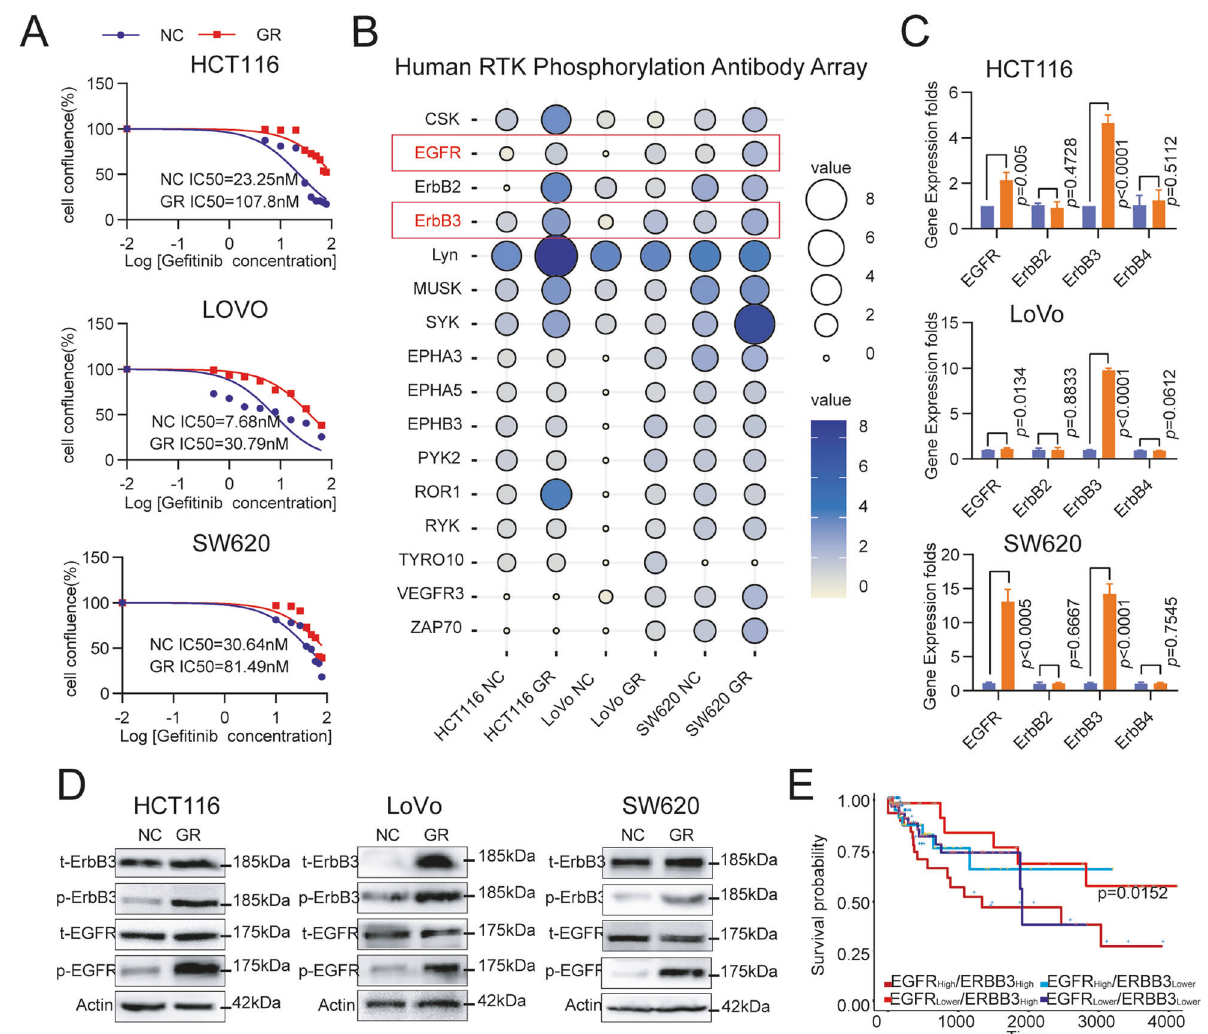
Fig. 1 ErbB3 and EGFR are activated in ge fi tinib-resistant CRC cell lines. A HCT116, LoVo, and SW620 cell lines were exposed to increasing concentrations of ge fi tinib for 48 h to determine the IC50 values by Celigo assay. B Detection of Phospho-RTK levels by the Phospho-RTK array in HCT116, LoVo, and SW620 cell lines. Cell was FBS starved for 24 h and stimulated with 20% FBS for ten minutes before harvesting. C The ErbBs mRNA levels in HCT116, LoVo, and SW620 cell lines were examined by qRT ‐ PCR. D ErbB3, and EGFR protein expression were